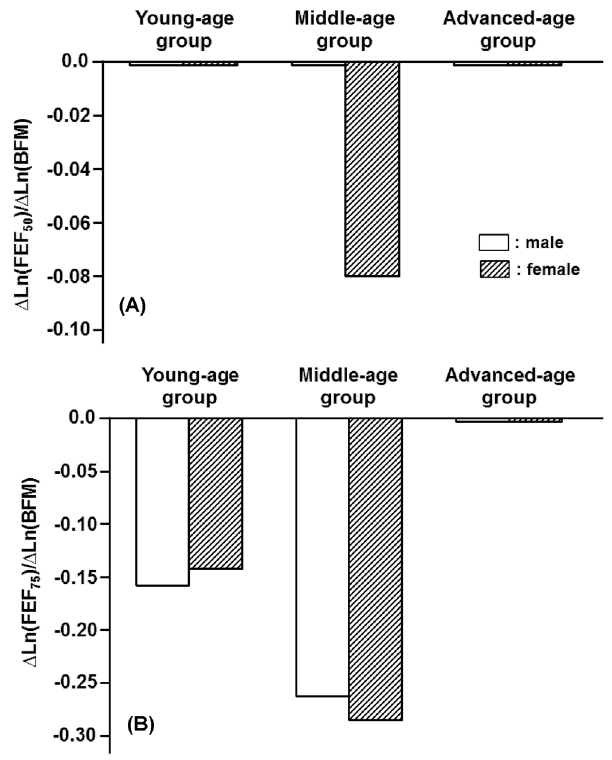
Figure 7. Age-specific impacts of body fat mass (BFM) on FEV 1 and FEV 1 /FVC estimated for three different age groups of both men and women. (A): Partial regression coefficients of Ln(BFM) for reference means of Ln(FEV 1 ) in young-, middle-, and advanced-age groups of either gender, which were expressed as D Ln(FEV 1 )/ D Ln(BFM). (B): Partial regression coefficients of Ln(BFM) for Ln(FEV 1 /FVC), being defined as D Ln(FEV 1 /FVC)/ D Ln(BFM).